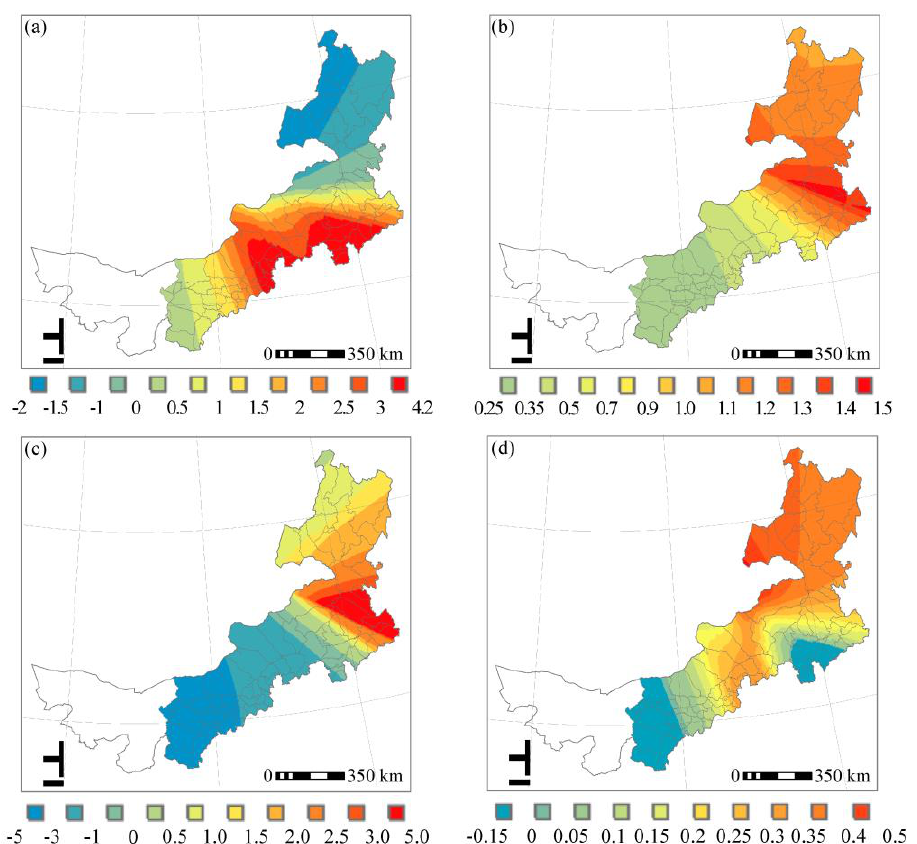
Figure 5. Regression coefficient of the explanatory variables against reduced carbon uptake (RCU) from GWR. Coefficient for ( a ) Grazing intensity, ( b ) Population density, ( c ) Road network density, and ( d ) Net primary productivity (NPP).